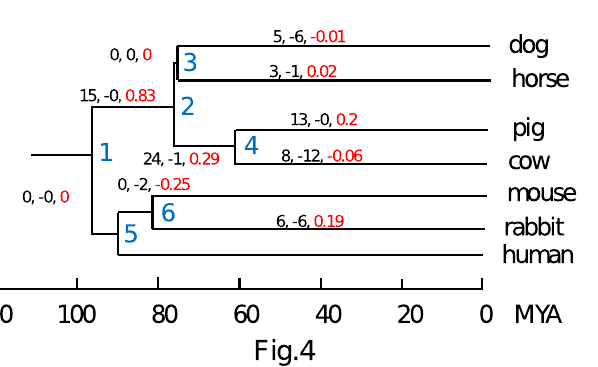
Table 3. The number of miRtrons and putatively repeat-derived miRNA